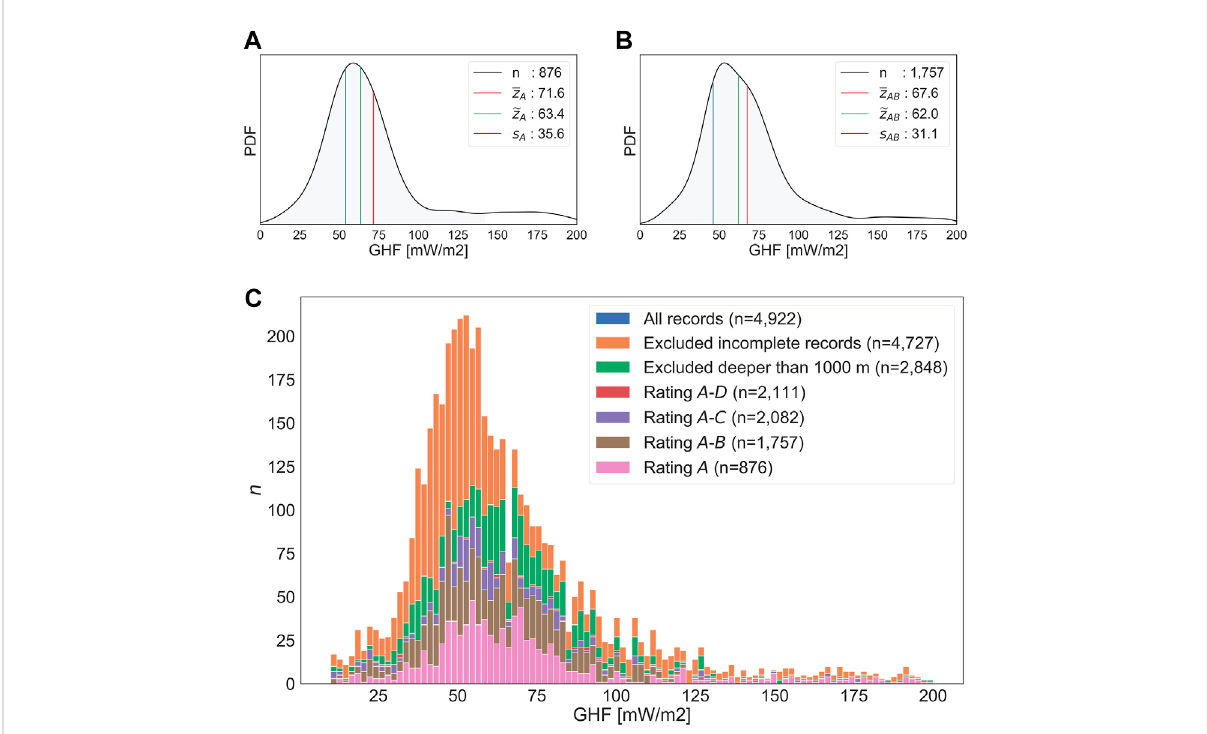
FIGURE 1 (A) Density plotof GHF measurements in Africa labeled A withoutquestionablevalues (B) Density plotof GHFmeasurements in Africa labeled A and B without questionablevalues, (C) Histogram ofbinned GHF measurements in Africainvolving all records, recordsafter removal ofquestionable and incomplete information, records after removal of deep-sea information, and records based on different quality ratings in the NGHF database. (Lucazeau, 2019). (cid:1) z = mean, ~ z = median, s = standard deviation.